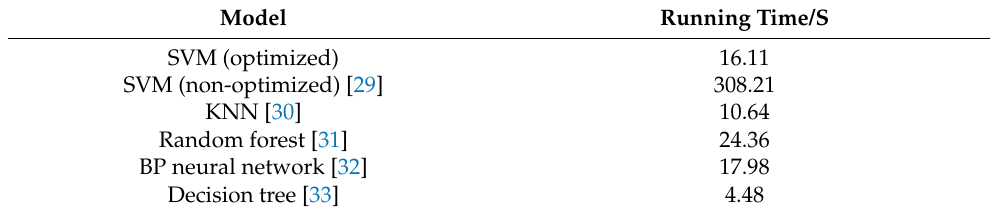
Figure 7. Comparison results of models. Table 7. Running time of different models.